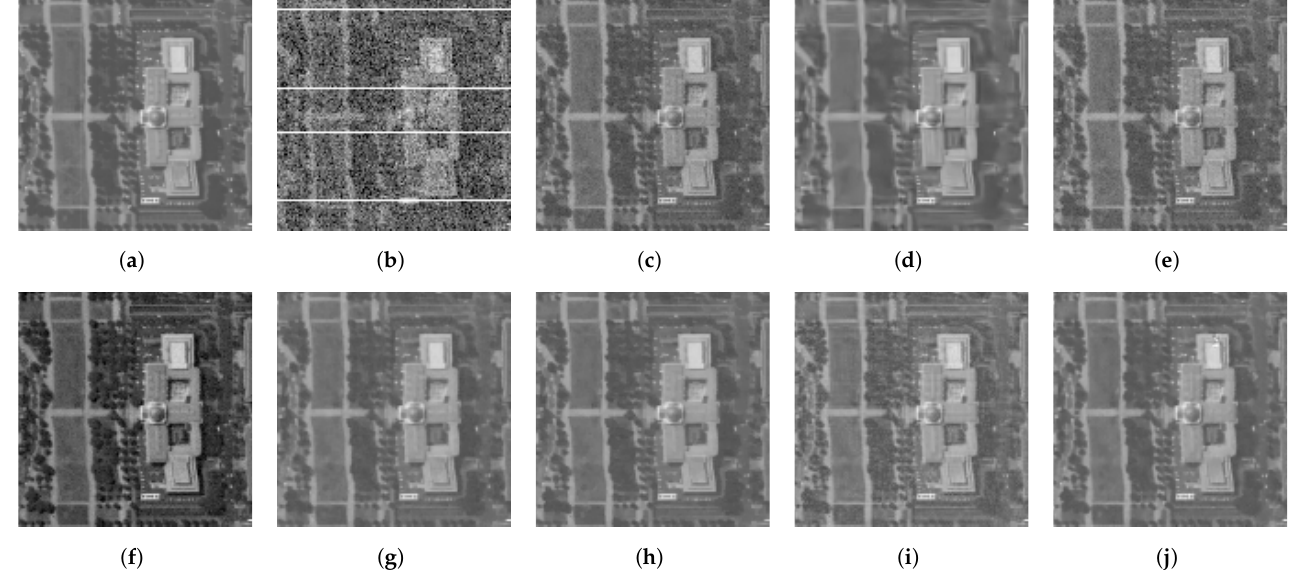
Figure 9. Case 5_1: The comparison of HSIs denoising results with existing methods on the Washing- ton DC Mall dataset: ( a ) ground truth of band 18; ( b ) noisy image; ( c ) NNM; ( d ) BM4D; ( e ) WNNM; ( f ) WSNM; ( g ) LRTDTV; ( h ) 3DTV; ( i ) FastHyDe; and ( j ) the proposed